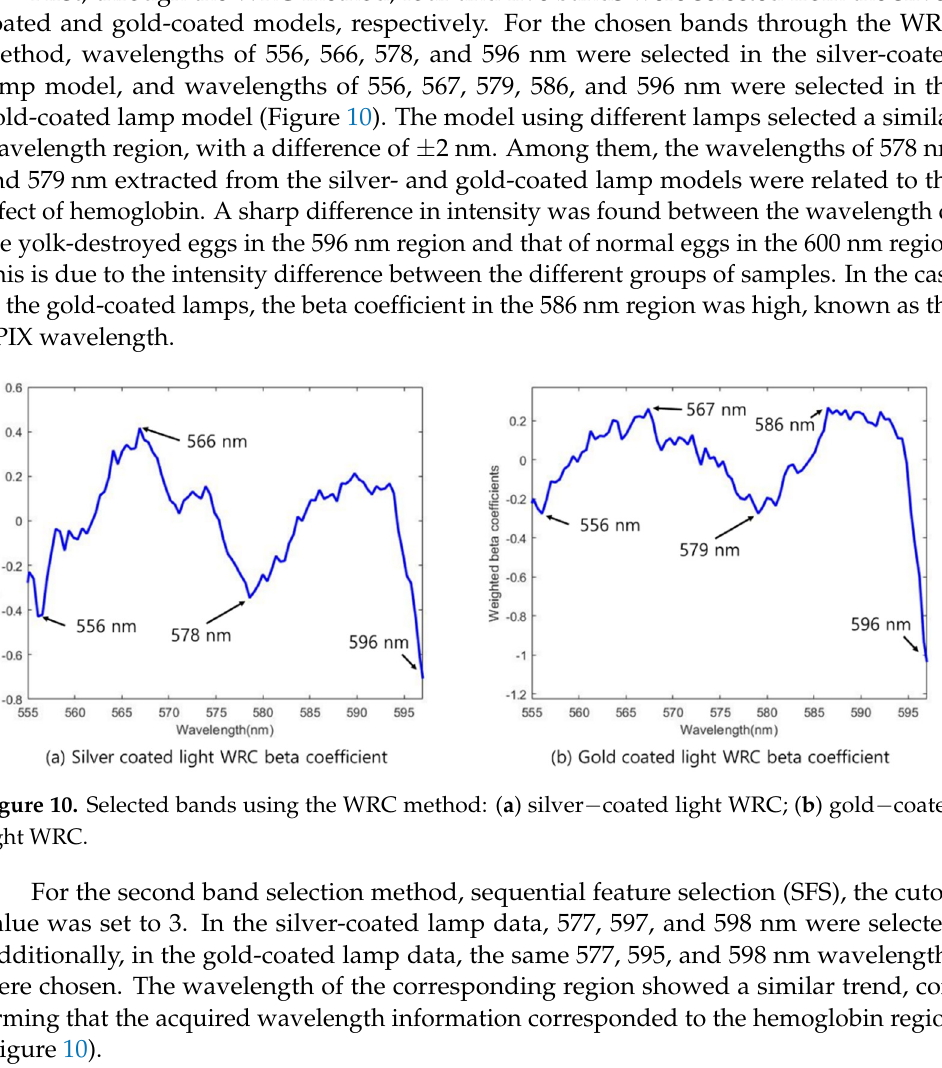
Table 2. The selected wavelengths for identifying the abnormal eggs using different variable selec- tion methods.